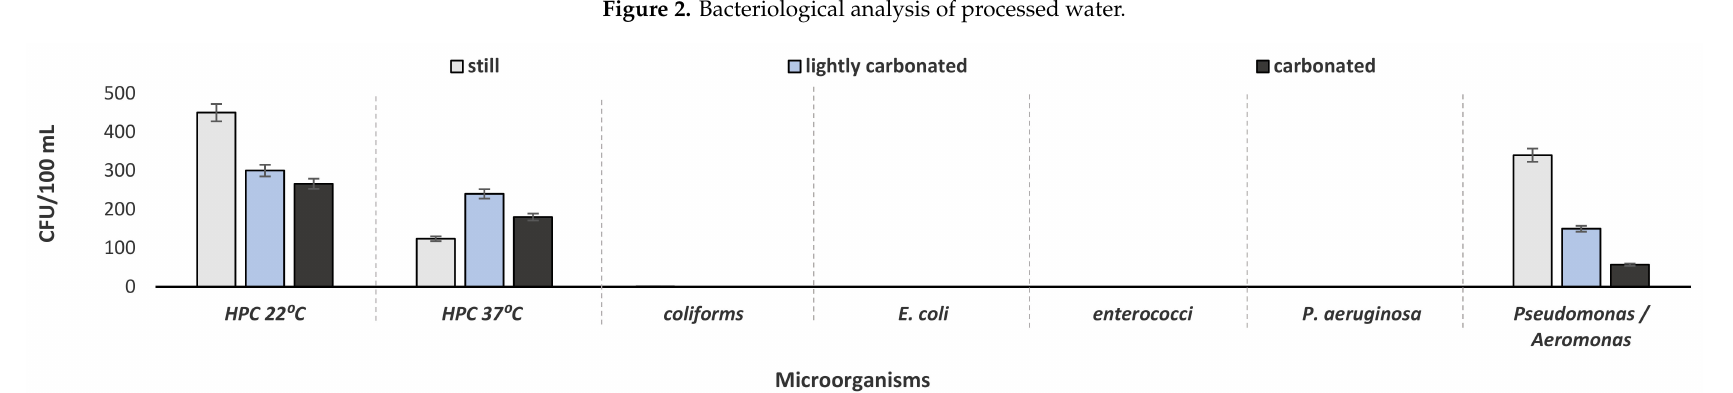
Figure 3. Bacteriological analysis of bottled